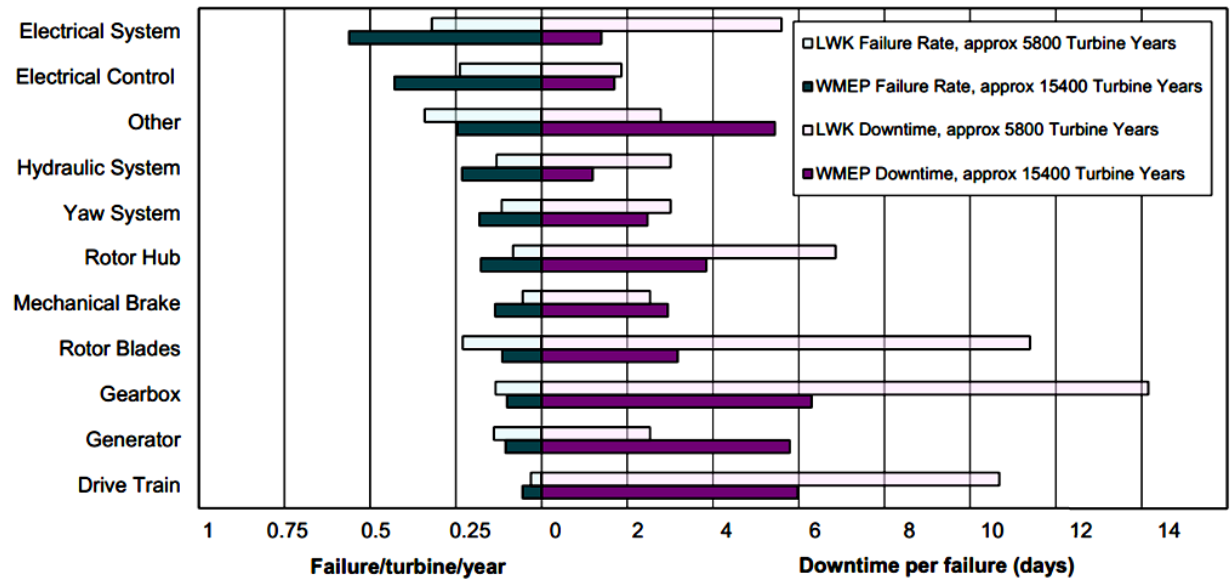
Figure 5. Failure rates and downtime from two large surveys of European WTs over 13 years [13]. Reprinted/Reproduced with permission from [13]. Copyright 2007, Springer Science + Business